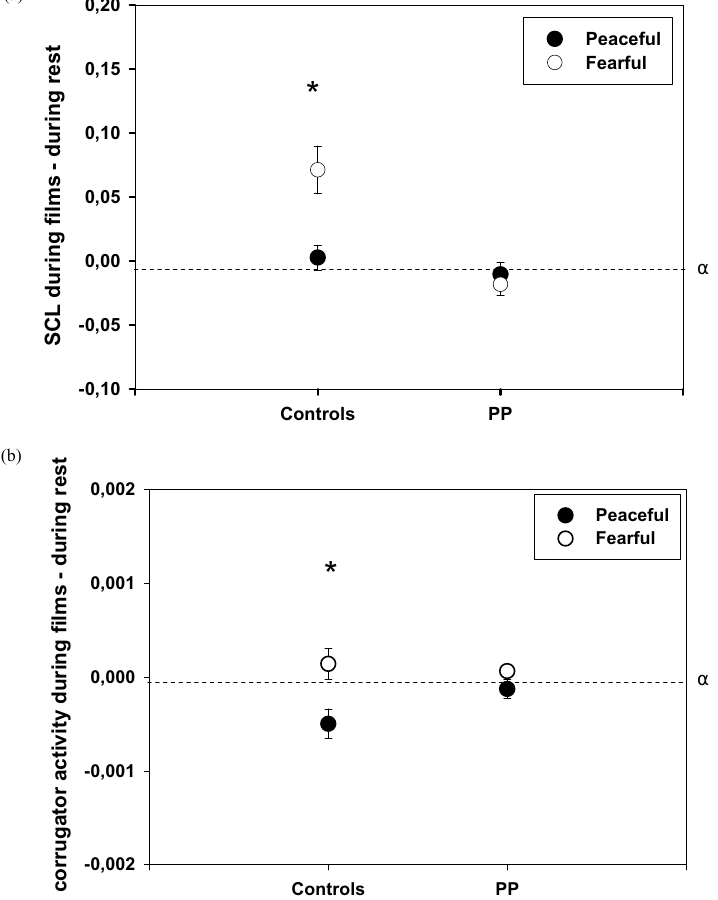
Fig. 2. Psychophysiological responses of patient and controls during peaceful and fearful film extracts viewing. P.P. failed to show an increase in: (a) skin conductance and (b) corrugator activity as found in controls for fearful films in comparison with peaceful